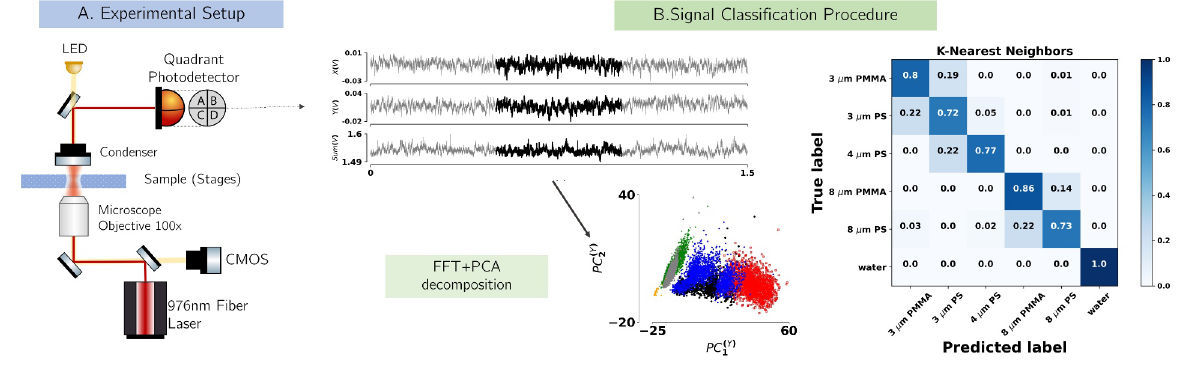
Figure 1. A. Visual summary of the Optical Tweezer system and signal classification procedure as described in the main text. B. Visual summary of the classification procedure and confusion matrix results for the particle dataset described in the main